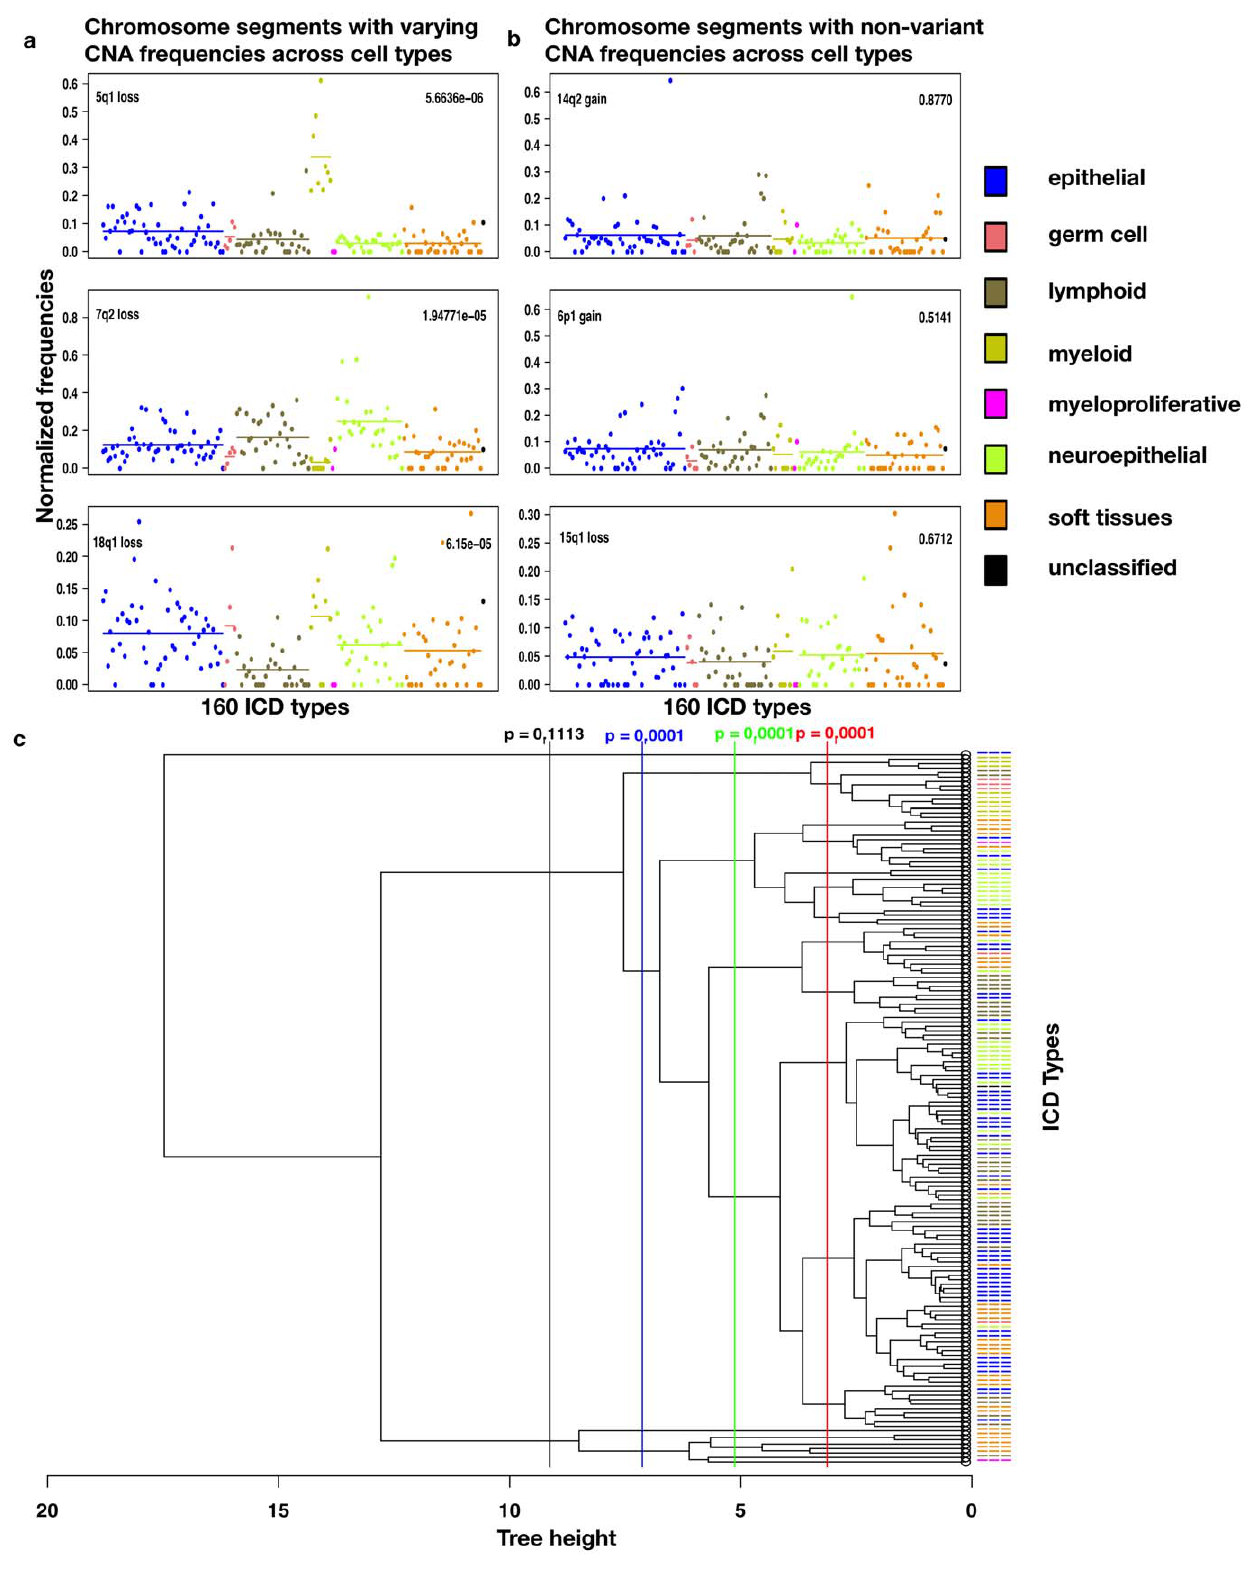
Figure 2. The tissue type of a cancer has a strong influence on its CNA likelihood pattern. a) examples of individual chromosome segments, showing their observed CNA frequencies stratified by cell type. Each dot summarizes all samples classified under one particular ICD type, color-coded by root cell type. In the left panel, three chromosome segments are shown that exhibit strong differences between cell types; on the right, three negative examples without such a signal. All p-values were corrected for multiple testing according to Benjamini-Hochberg. b) the